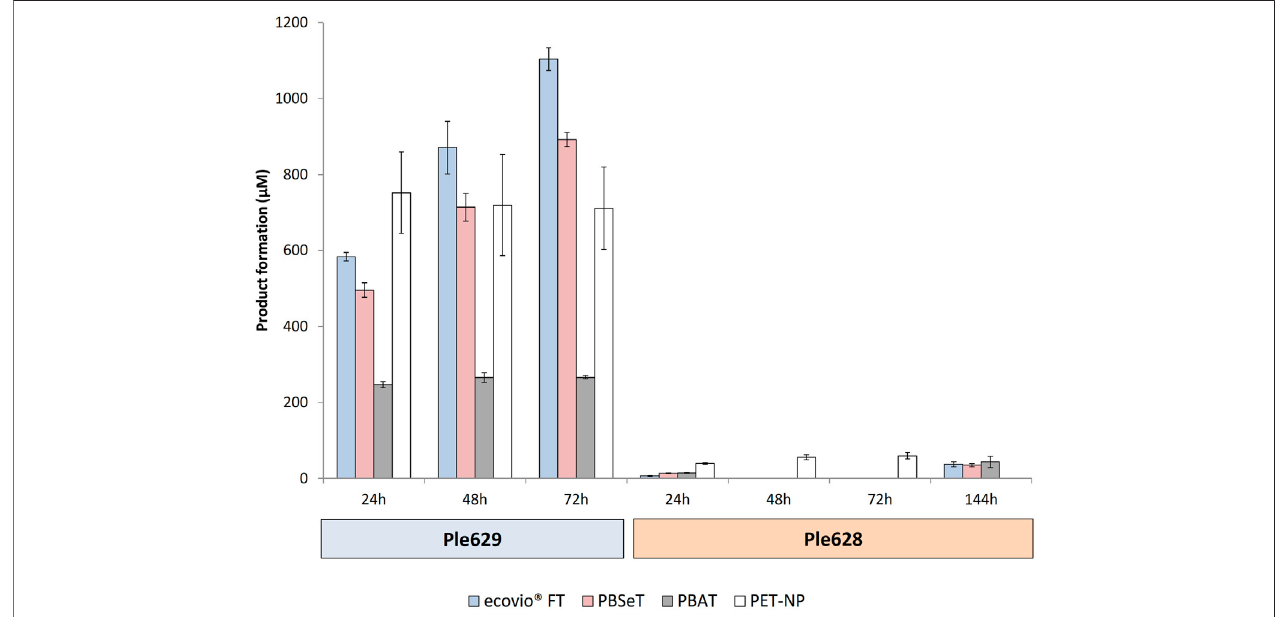
FIGURE 4 | Degradation of biodegradable plastics and PET-NP by Ples. Formation of BT or MHET (in µM) after degradation of ecovio ® FT (light blue), PBAT (light gray), PBSeT (dark pink) and PET-NP (white) by Ple629 and Ple628. The degradation of biodegradable plastics and PET-NP leads to the formation of BT and MHET, respectively. The sampling points are shown at 24, 48, 72, and 144 h. The error bars indicate the standard deviation ( n =